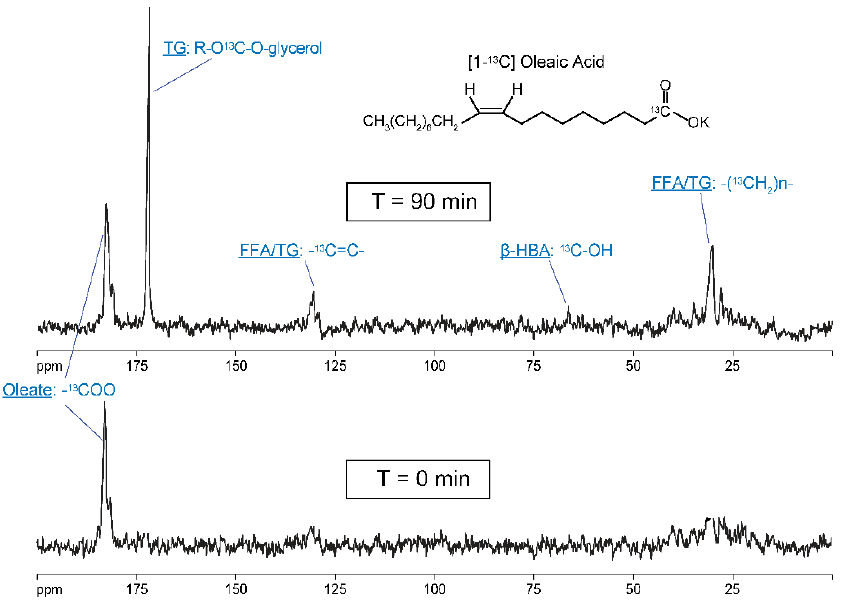
Figure 10. Development of a perfused liver assay of lipid metabolism. Shown are spectra acquired as early as possible after liver excision (T = 0 min), and after 90 min of metabolizing [1- 13 C] oleate. The NMR signals in the top spectrum demonstrate the ability to measure the synthesis of triglycerides, fatty acid oxidation, as well as recycling of lipid in real time.